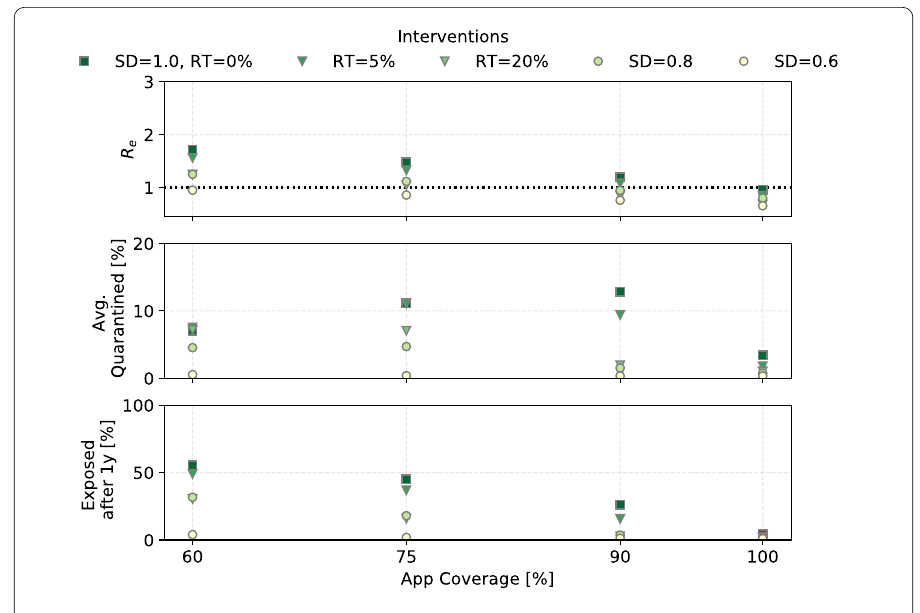
Figure 10 The effect of social distancing (SD) and random testing (RT) for different app coverages in combination with CT ( R 0 = 3, η DCT = 1, α · f m = 0.6)